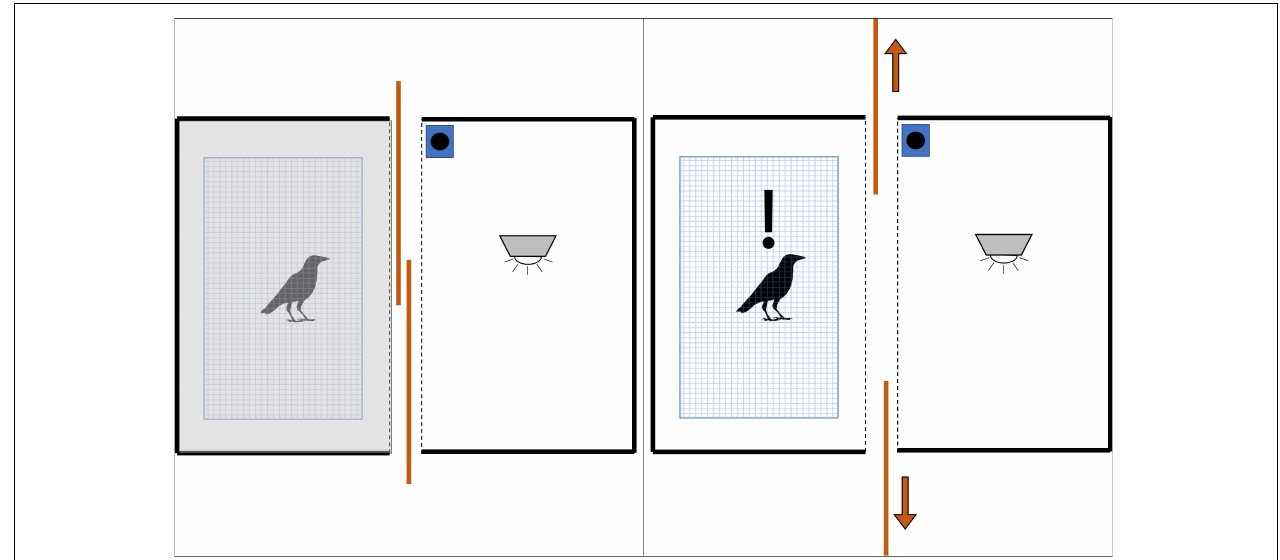
FIGURE 1 | Graphic of experimental layout during stimulus phase (top-down view). The fume hood surrounding the crow’s cage blocked all view of the surrounding laboratory. When we closed the sliding panels between the crow’s cage and the stimulus stage (left), the crow was plunged into relative darkness. We revealed the interior of the well-lit stage (and any stimulus within it) by opening the sliding panels